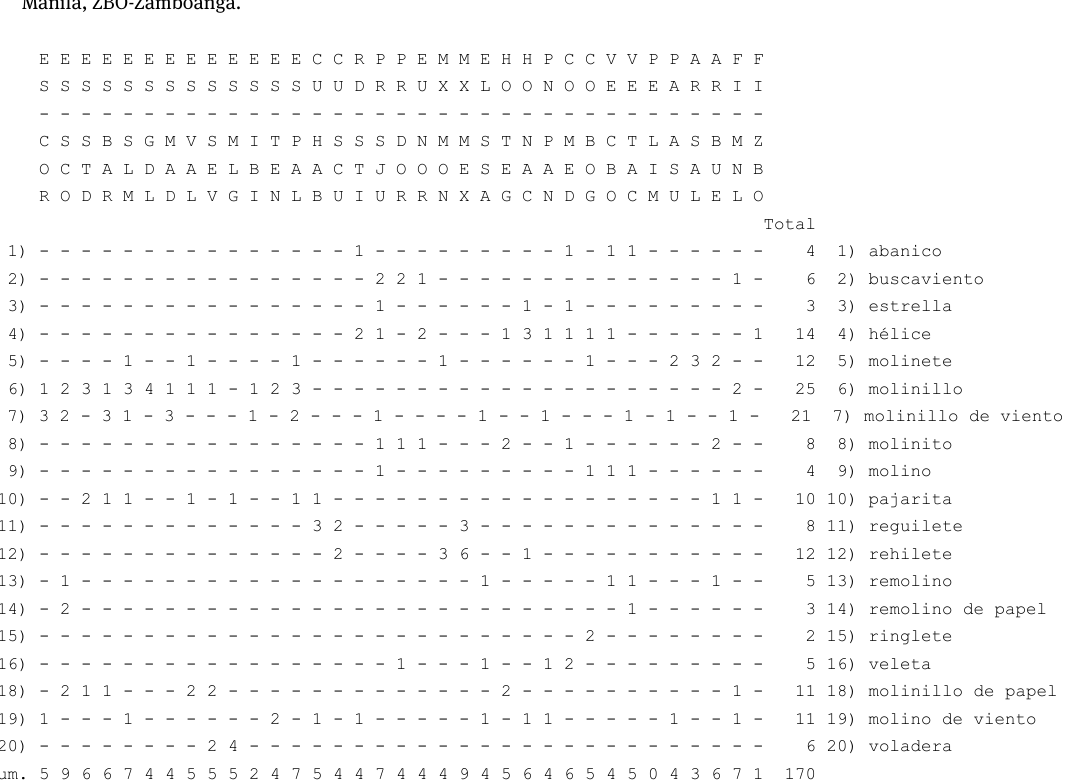
Table 2. Responses obtained for the lexical variants of the concept ‘molinillo; hélice; rehilete ’’ (windmill/pinwheel) by country and city. Country codes: ES (Spain); CU (Cuba); RD (Dominican Republic); PR (Puerto Rico); EU (United States); MX (Mexico); EL (El Salvador); HO (Honduras); PN (Panama); CO (Colombia); VE (Venezuela); PE (Peru); PA (Paraguay); AR (Argentina); FIL: Philippines. City codes: COR-A Coruña, SCO-Santiago de Compostela, STD-Santander, BAR-Barcelona VAL-Valencia